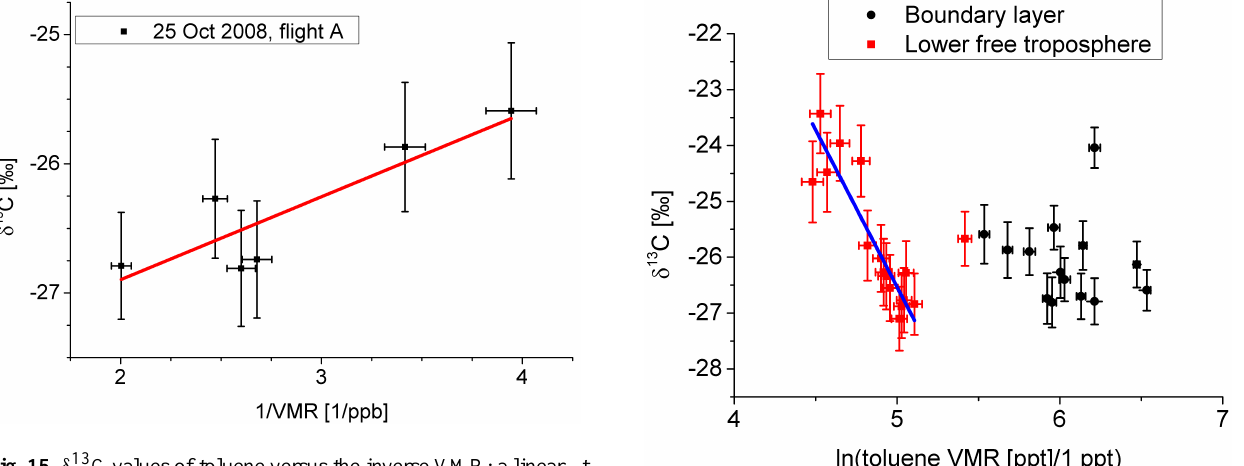
Fig. 15. δ 13 C values of toluene versus the inverse VMR; a linear fit (red line, Pearson R =0 . 87 ) is applied to the data. Fig. 16. Toluene δ 13 C values versus the logarithm of the corresponding VMR, divided by 1 ppt (see text for details); the height regimes (PBL and LFT) are clearly distinguishable. A linear fit (blue line, Pearson R = − 0 . 91 ) is applied to the LFT data (one data point shows a rather PBL- like characteristic and is therefore excluded), yielding an effective KIE of ε eff =5 . 10 ± 0 . 75 ‰.